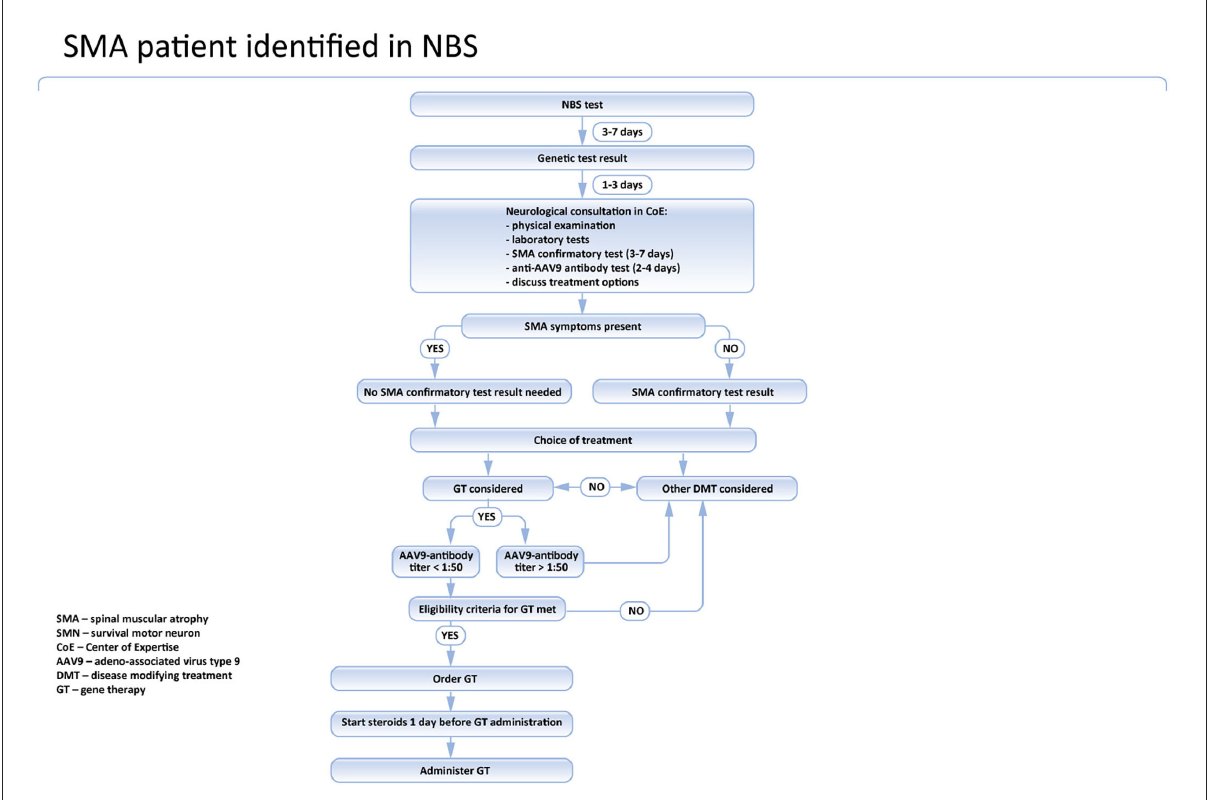
FIGURE2 Pathway of SMA patient identified in the NBS program in Poland.